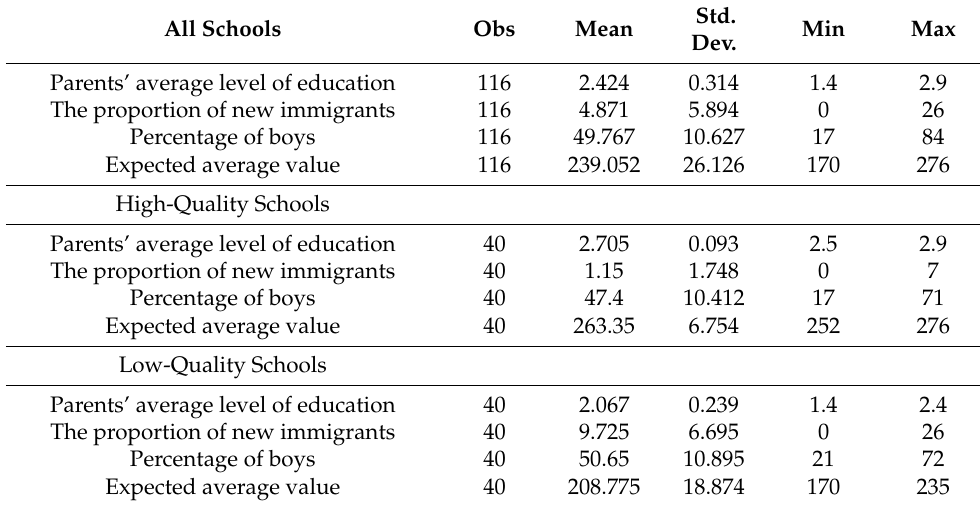
Table 2. Descriptive statistics for Measure 2: expected average value.